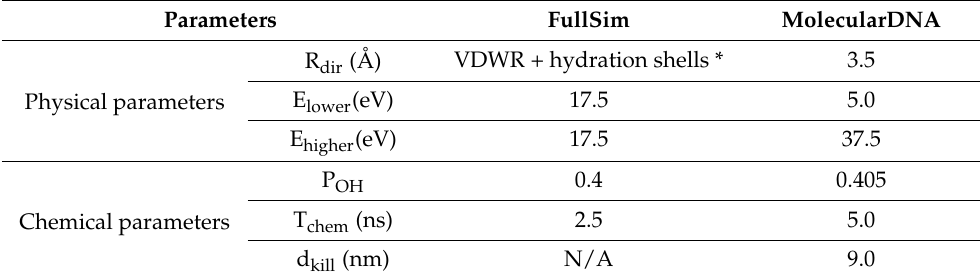
Table 4. Main parameters of FullSim and MolecularDNA simulation chains for predicting early DNA